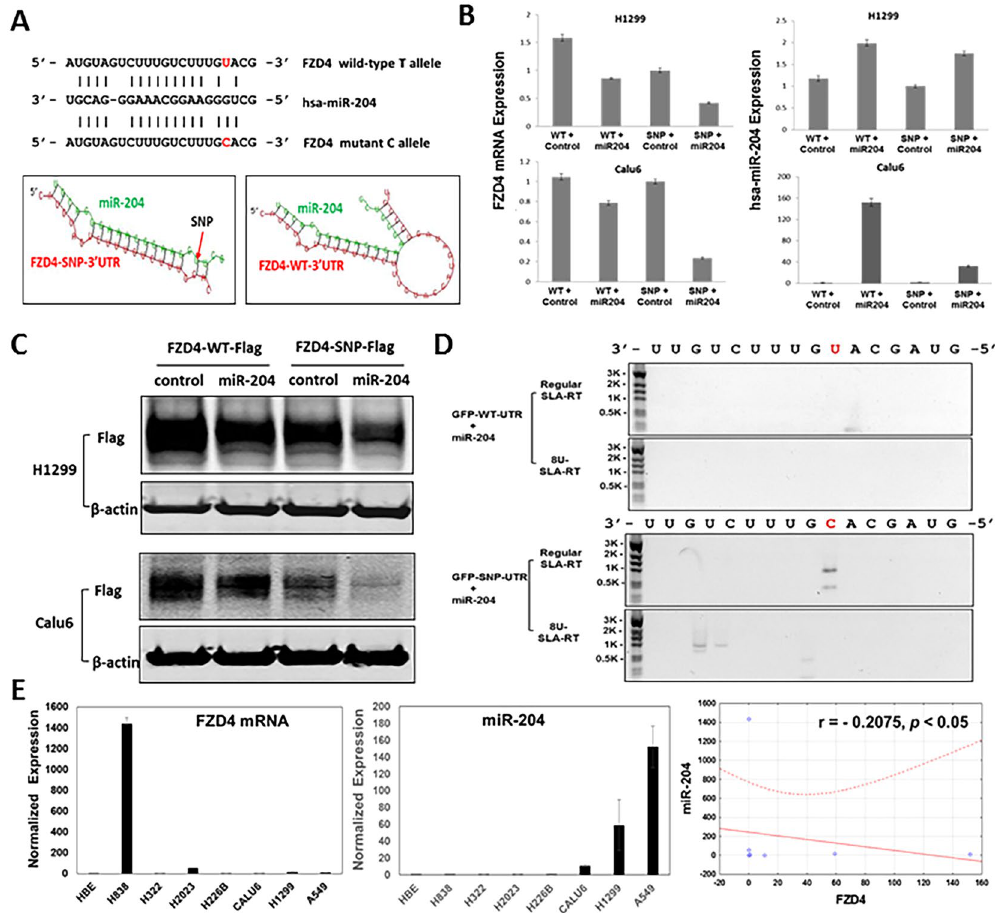
Figure 3. The differential regulation of target binding and gene expression in FZD4 3 ′ UTR at the allelic variants of rs713065 loci by miR-204. (A) The complementary sequences and predicted secondary structures of miR-204 to FZD4-SNP and WT allelic variants at rs713065. At rs713065, the SNP variant C Watson-Crick base-pairs with G (shown in red) and favorable miRNA:mRNA binding pattern and secondary strucure, while the wildtype U allele wobble base-pairs with G. (B) Over-expression of miR-204 reduces intracellular levels of the FZD4-SNP-3 ′ UTR mRNA, as determined by quantitative RT-PCR. (C) Over-expression of miR-204 leads to down-regulation of FZD4 protein in FZD4-Flag-SNP transfected H1299 cells, as determined by Western blot (see supplementary Fig. S4 for full length gel images). (D) miR-204 selectively induces SNP-3 ′ UTR mRNA transcript cleavage, as detected by specific SLA-RT-PCR. ( E ) Expression of endogenous miR-204 and FZD4 and their correlation in NSCLC cell lines by a quantitative real-time RT-PCR analysis. A significant correlation (r = − 0.2075, p < 0.05) between the endogenous mature miR-204 and the FZD4 mRNA expression was demonstrated by a Pearson’s correlation